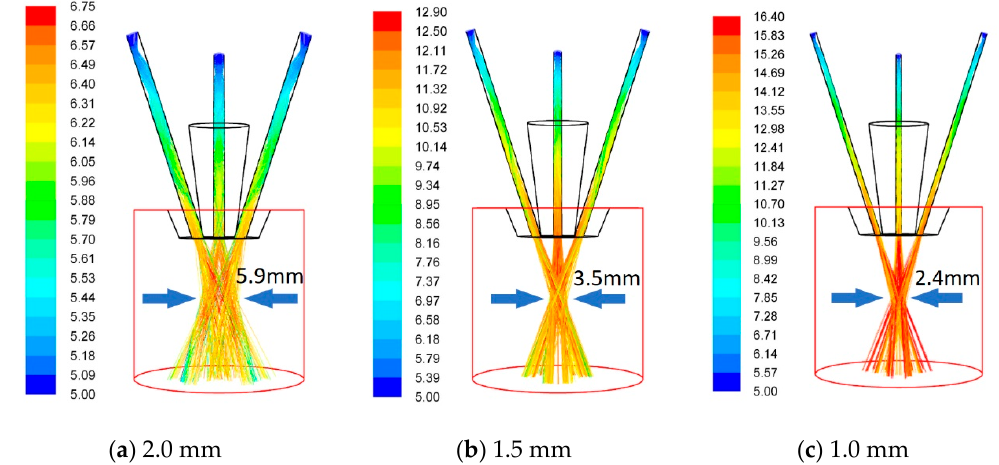
Figure 8. The influence of different passage diameters on powder focus spot size. ( a ) 2.0 mm; ( b ) 1.5 mm; ( c ) 1.0 mm.